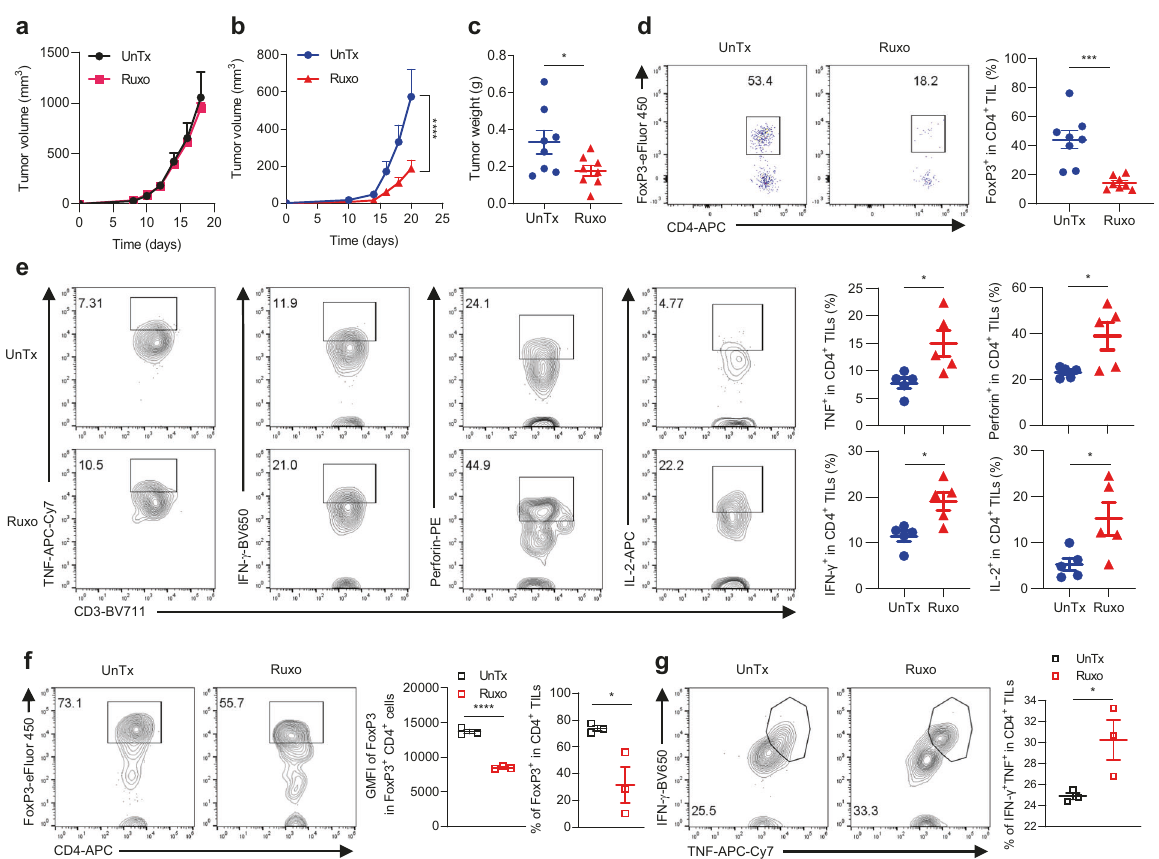
Fig. 6 | Ruxo suppresses IFN γ R1 KO but not scrambled control melanomas. a Growth of scrambled control melanomas in B6 mice treated with vehicle (UnTx, n =5)orwithRuxo(90mg/kgbyoralgavagetwicedaily)( n =5)for10days. b – e B6 mice bearing IFN γ R1 KO melanoma were treated as in a . b Tumor growth : n =8 per group; **** p =0.0002 by two-way ANOVA with Š ídák ’ s multiple comparisons test. c Tumorweightsateuthanization( n =8pergroup;* p =0.0422).IsolatedTILsfrom these mice were analyzed for frequency of FoxP3 + T reg ( d ) ( n =8 per group; **** p =0.0003) and cytokine production of TNF, IFN- γ , Perforin, and IL-2 in CD4 +